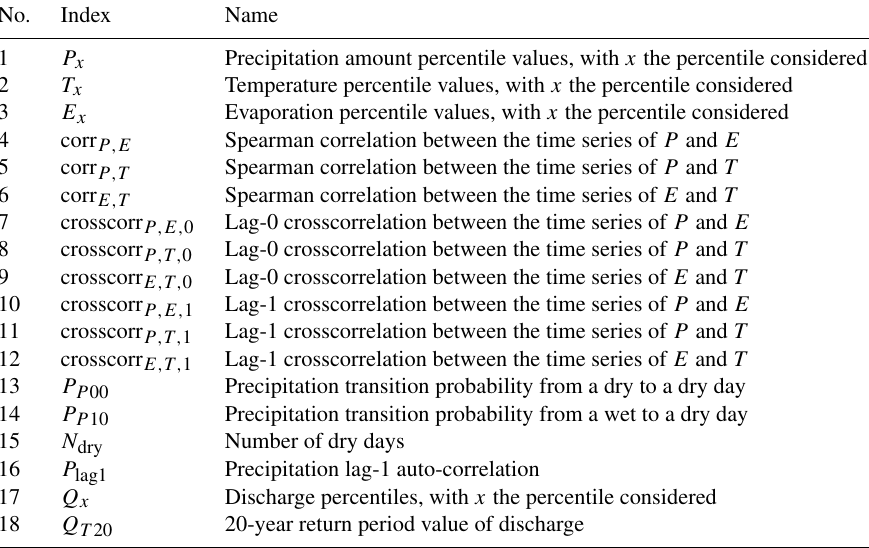
Table 1. Overview of the indices